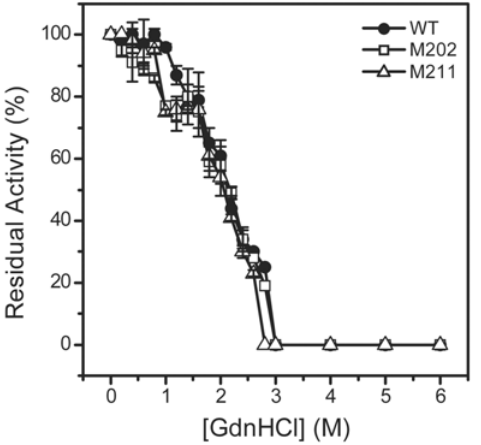
Figure 4. Inactivation of the WT and mutated TcSOD by GdnHCl. The enzymes were denatured in 20 mM phosphate buffer, pH 7.4, in the presence of various concentrations of GdnHCl for 12 h at 4 ° C. The final protein concentration was 0.27 mg/mL. The residual activity was normalized by taken the activity of the enzyme in buffer without GdnHCl as